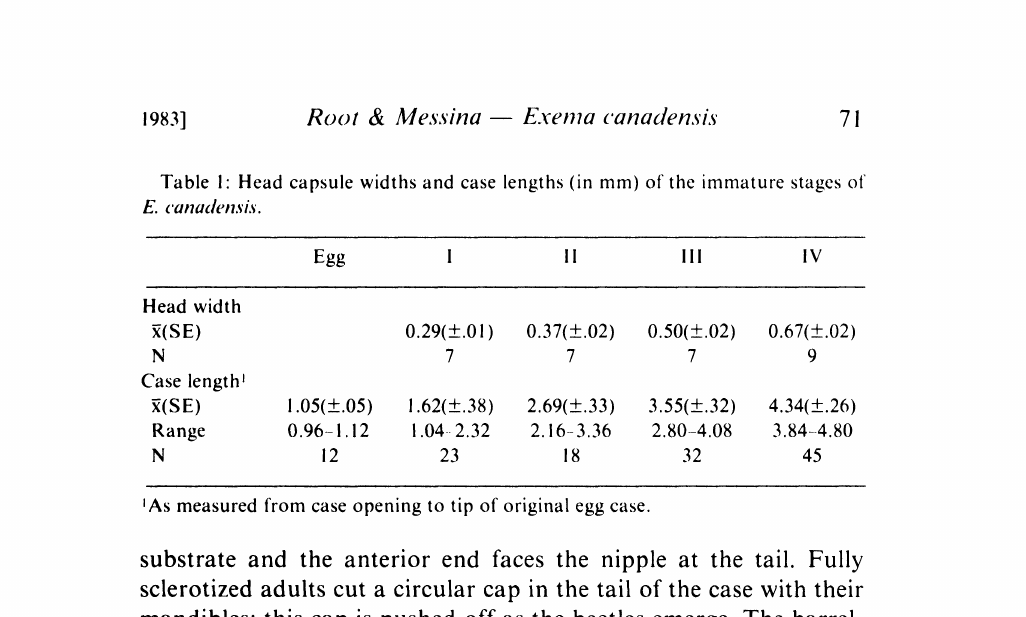
Table I" Head capsule widths and case lengths (in mm) of the immature stagcs of E. canadensis.